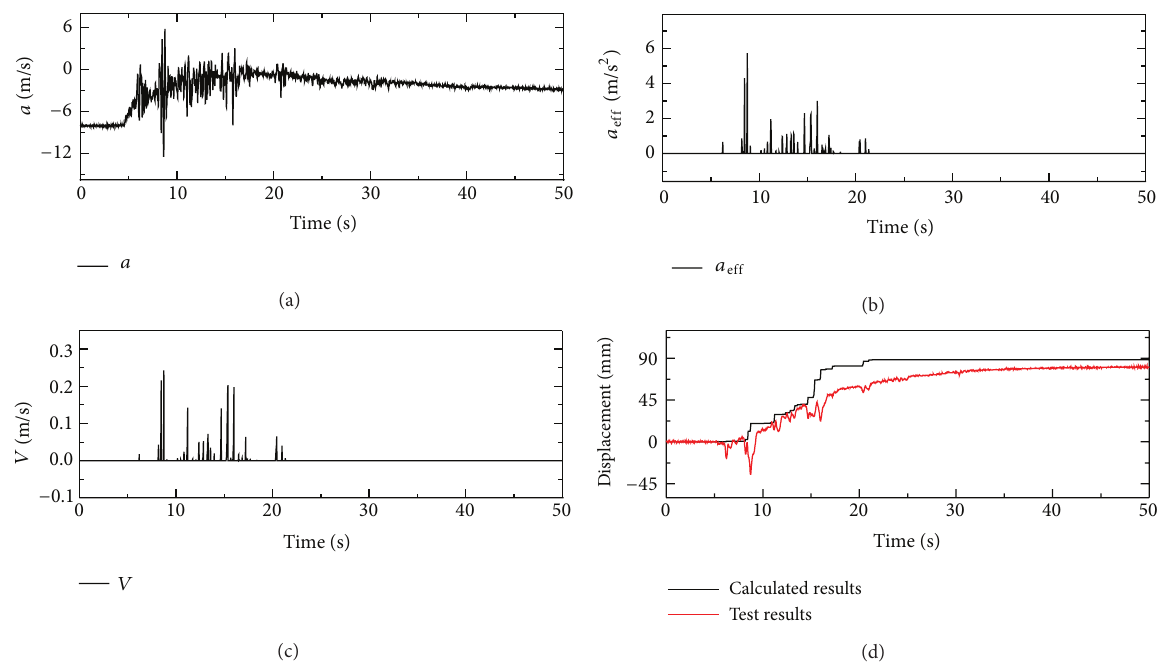
Figure 16: Acceleration, velocity and displacement of pipe 1# under 0.4 g Taft wave in test